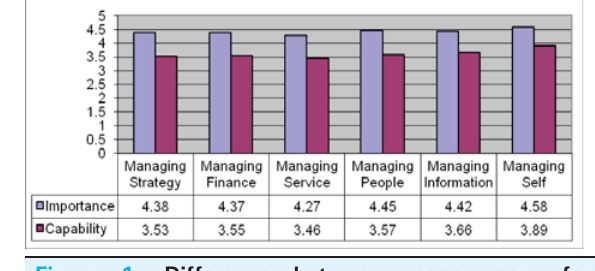
Figure 1. Difference between mean score for reportedImportance and Capability for Doctors (n = 39)